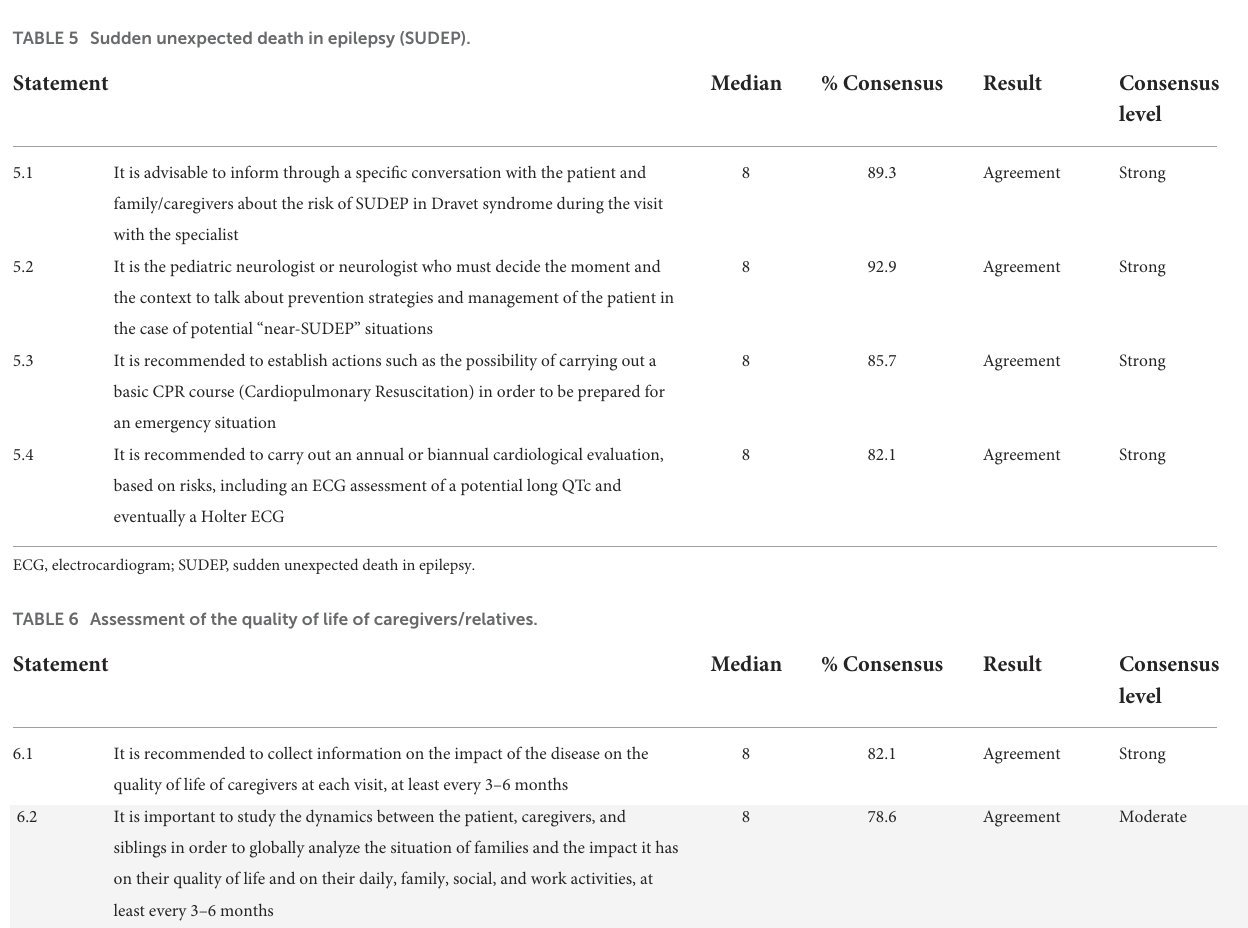
TABLE 5 Sudden unexpected death in epilepsy (SUDEP).